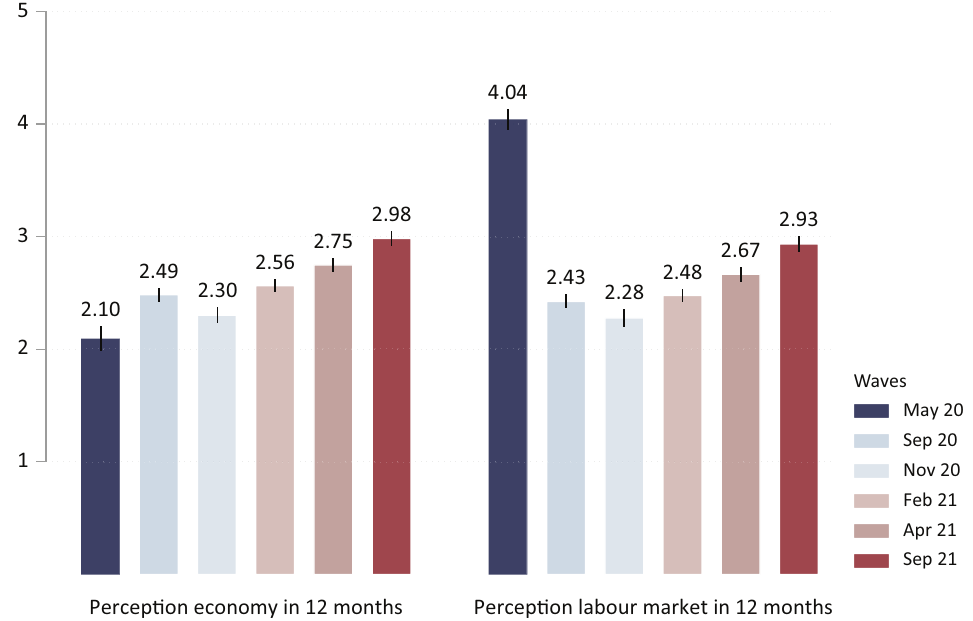
Figure 5. Average dispositional optimism towards the future Italian economy and labour market, over survey waves (N = 11,350). Source: Authors’ work based on Bank of Italy